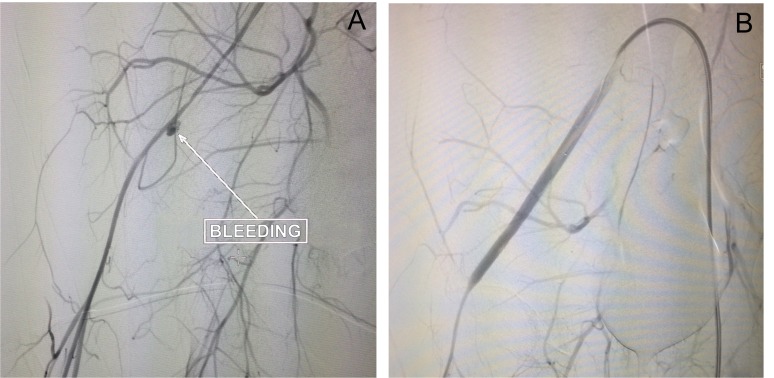
Images of endovascular treatment of hemorrhaging aneurysm at the puncture site using a covered stent. Initial arteriography (A); Final arteriography (B).